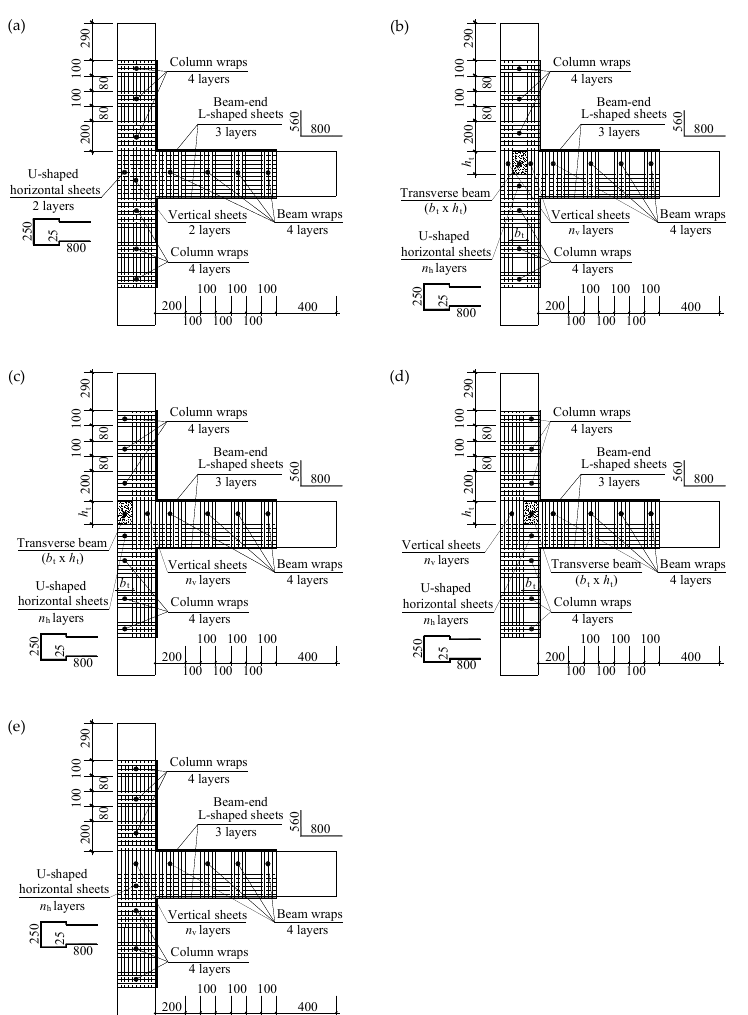
Figure 3. Strengthening schemes (all dimensions are in mm; the values of b t , h t , n h and n v for each of the specimens are listed in Table 1). ( a ) Specimen TJ-3; ( b ) Group DM; ( c ) Group DE; ( d ) Group DI; ( e ) Group SM/SE/SI (the free side of the joint